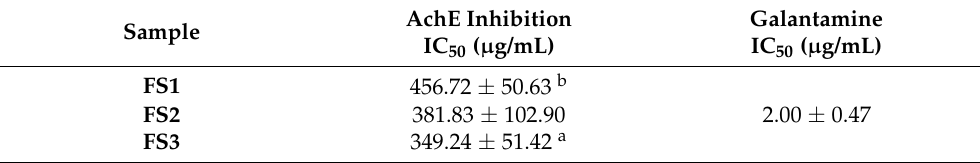
Table 5. Results of the anti-cholinesterase activity assays for the tested F. schleicheri samples.